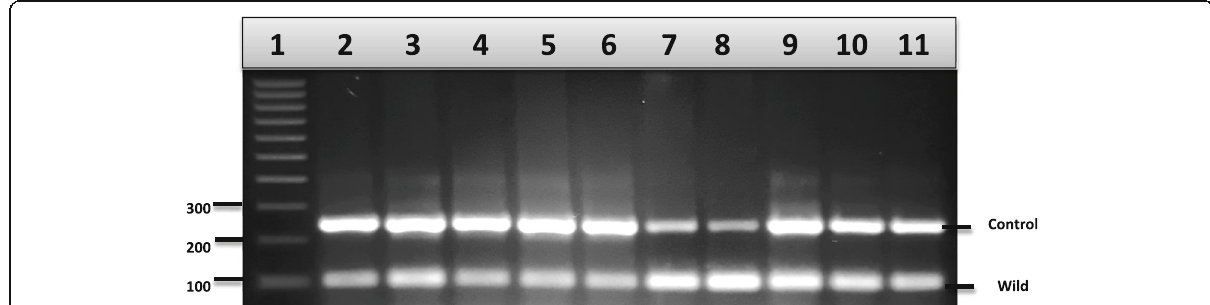
Fig. 1 Electrophoresis of amplified PCR products to detect MPL p. W515 L/K pathological variants by ARMS technique. Left to right: lane 1 is 100-